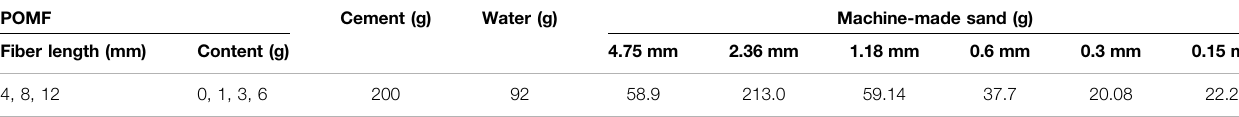
TABLE 1 | Mix design of the POMF-reinforced mortar material.